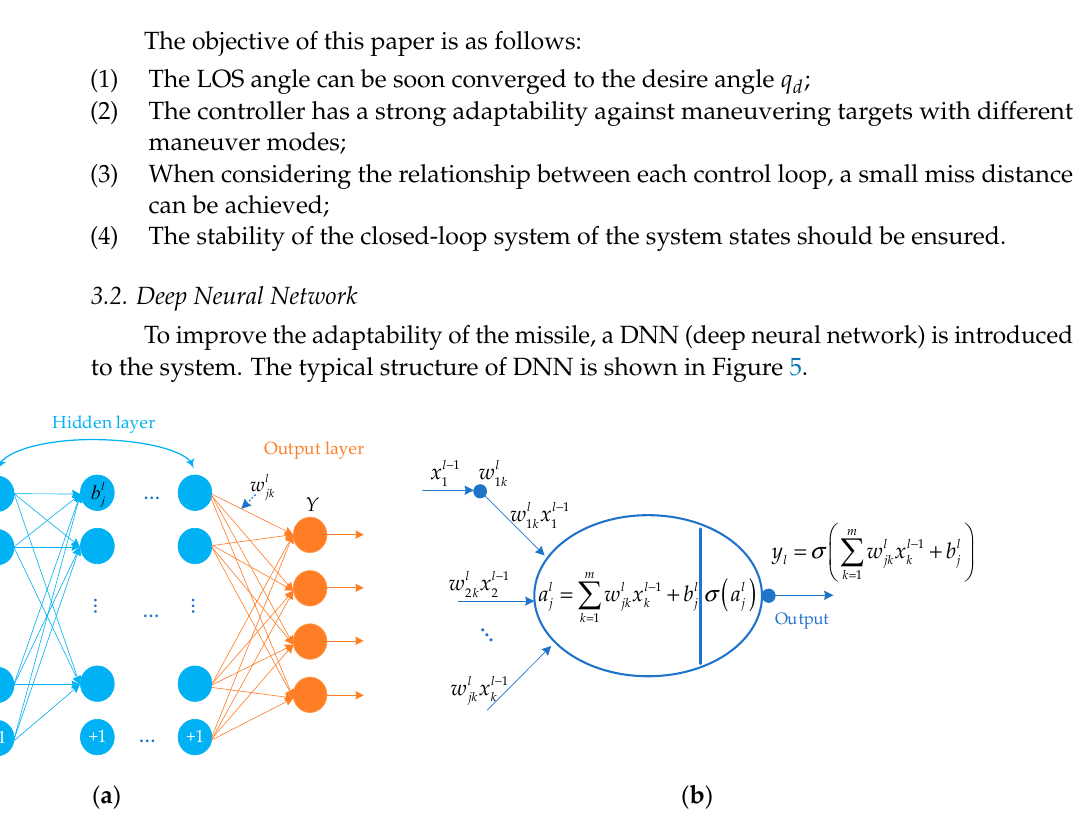
Figure 5. ( a ) Structure of deep neural network. ( b ) The structure of a neuron model. Like other neural networks, the deep neural network also consists of an input layer, a hidden layer, and an output layer. In hidden layers, each neuron is fully connected, meaning any neuron in hidden layers l must be connected with any neuron in hidden layers l + 1 and l − 1. According to the specific problem, we can construct the appreciate networks with different hidden layers. As shown in Figure 5a, X = [ x 1 , x 2 , · · · , x n ] denotes the input vector, and x i is the i th element of X . w l represents the weight from the k th jk neuron in the ( l − 1 ) th hidden layer to the j th neuron in the l th layer. Y = [ y 1 , y 2 , · · · , y n ] denotes the output vector, as can be seen in Figure 5b, which gives the computational structure of neurons. x l − 1 denotes the k th neuron in the ( l − 1 ) th layer. b l denotes the j j k